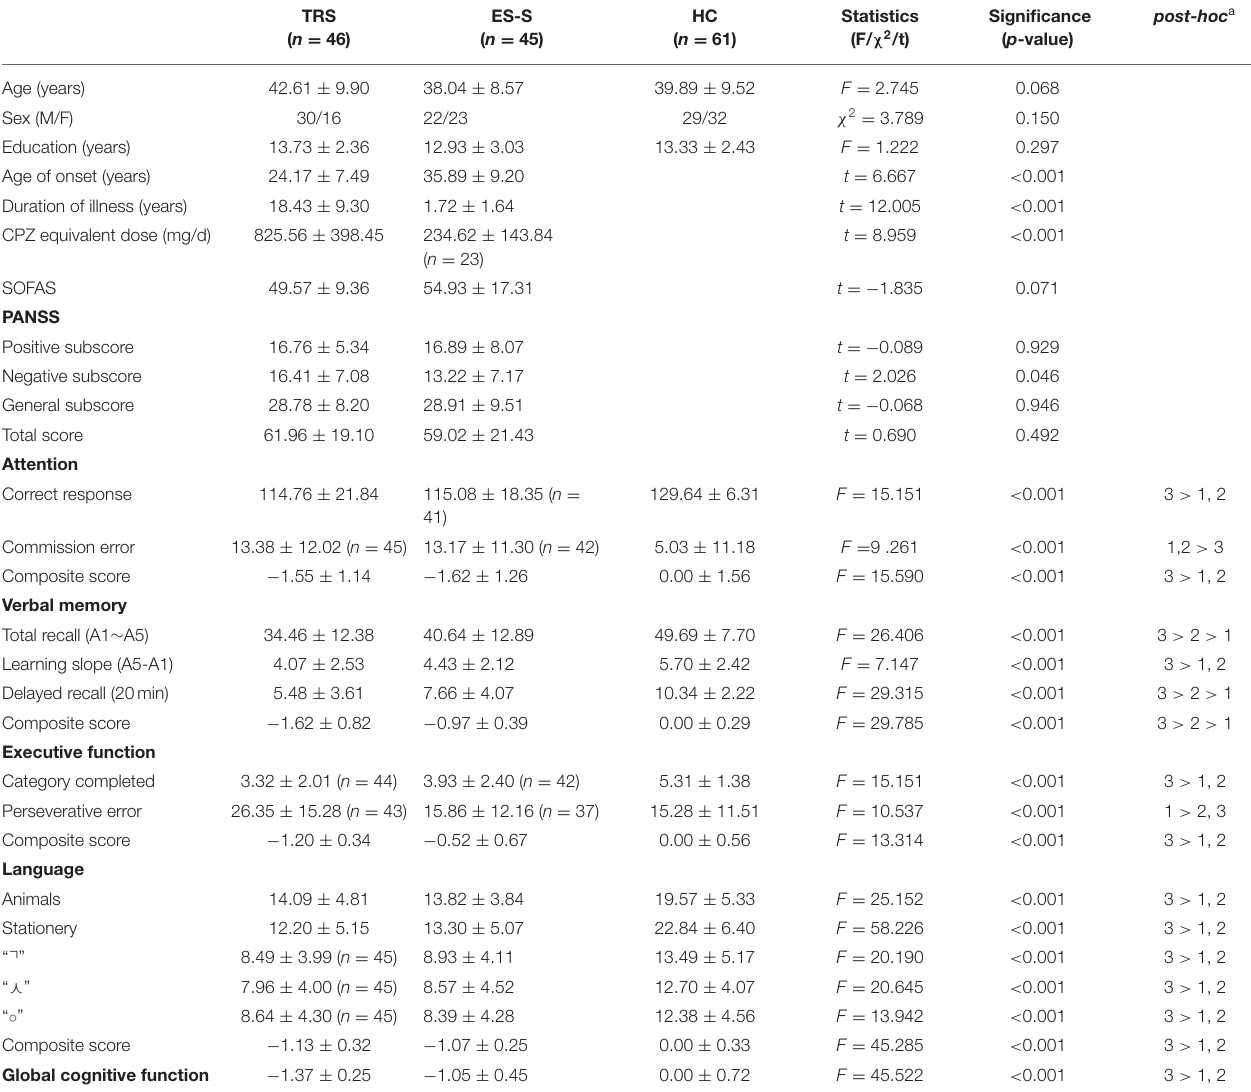
TABLE 1 | Demographic and clinical characteristics and cognitive measures of patients with TRS and ES-S, and HC.